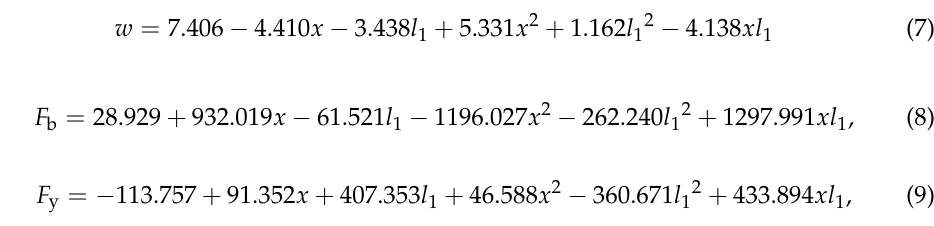
Figure 16. Effects of the installation location. ( a ) Support force; ( b ) deflection and bending moment amplitudes.